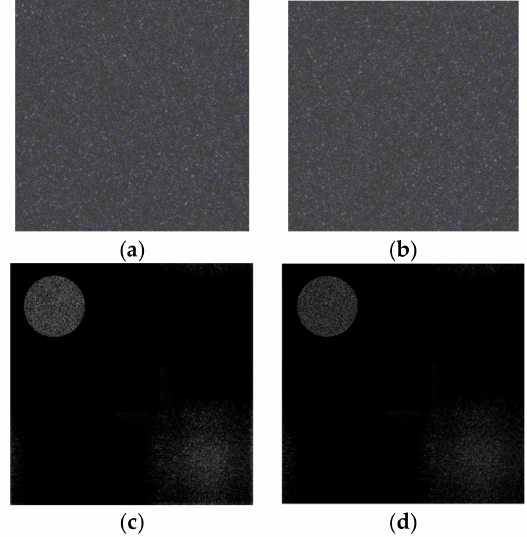
Figure 8. The holograms before and after deformation. ( a ) holograms ( t 1); ( b ) holograms ( t 2);